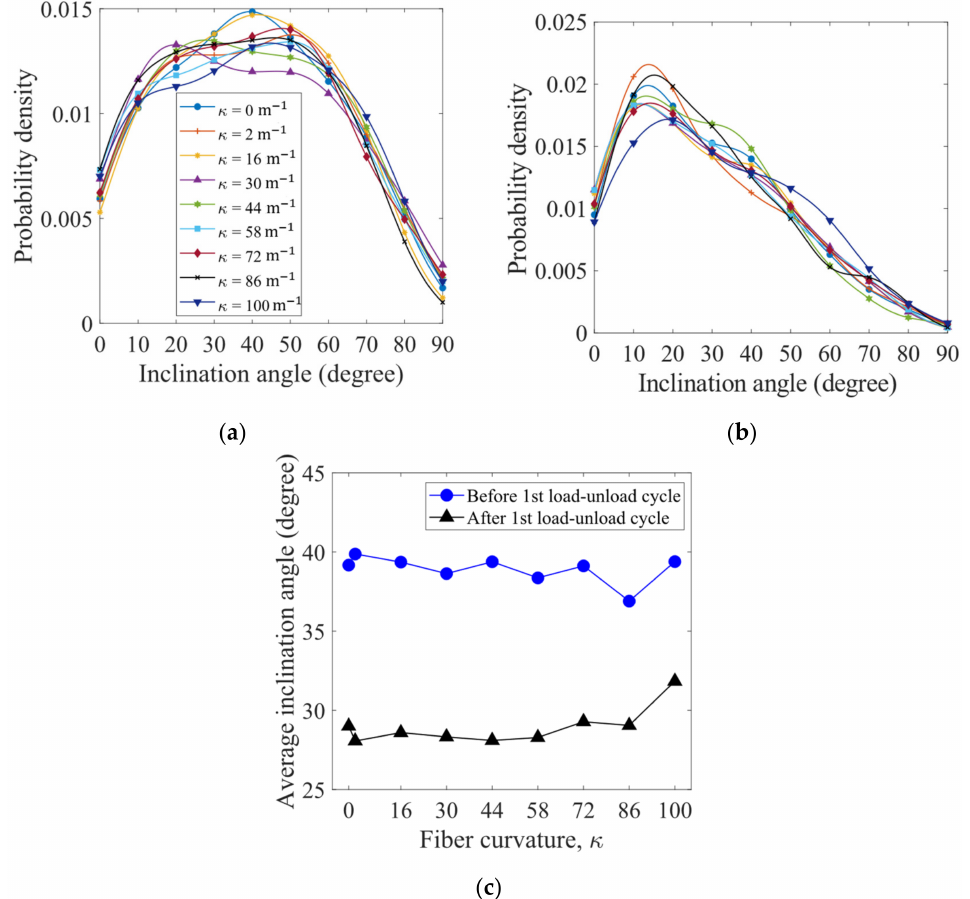
Figure 11. Probability density distributions of fiber inclination angles for the packings ( a ) before and ( b ) after the first load–unload cycle. Average inclination angle as a function of fiber curvature is plotted in ( c